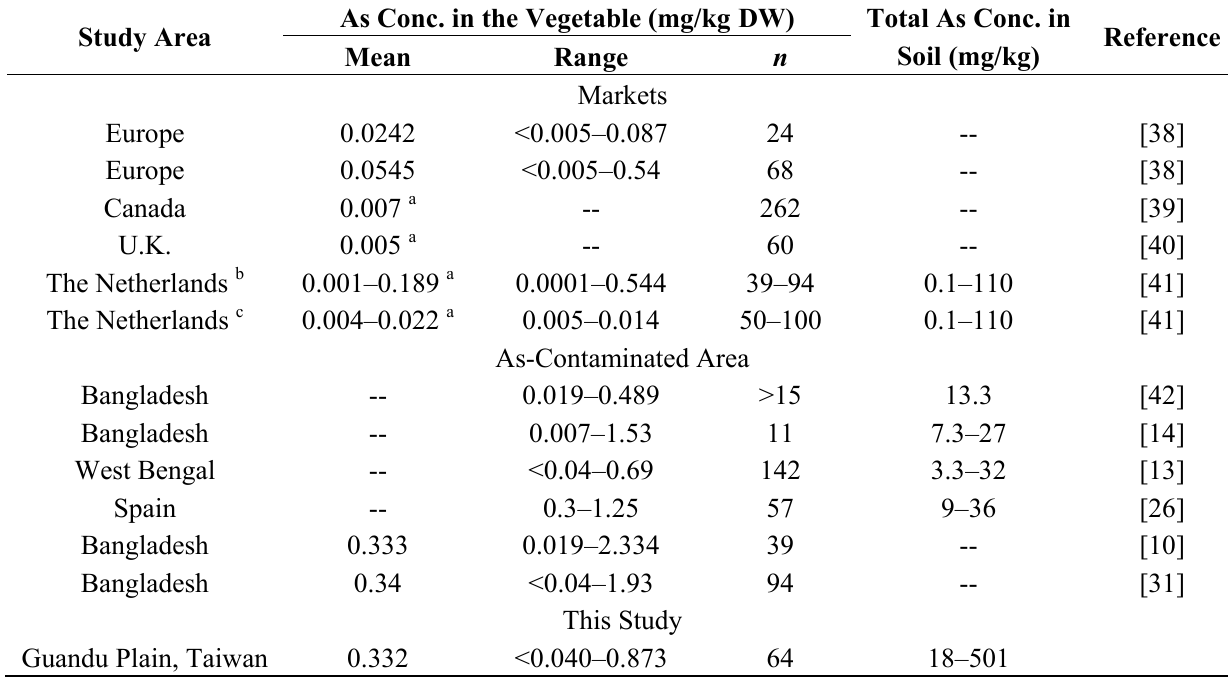
Table 4. As concentrations in vegetables and soils reported in literature and in this